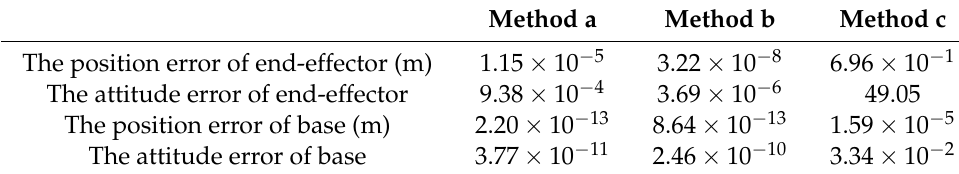
Figure 5. The minimum disturbance between arm and collision point. Table 4. The precision table of three comparing